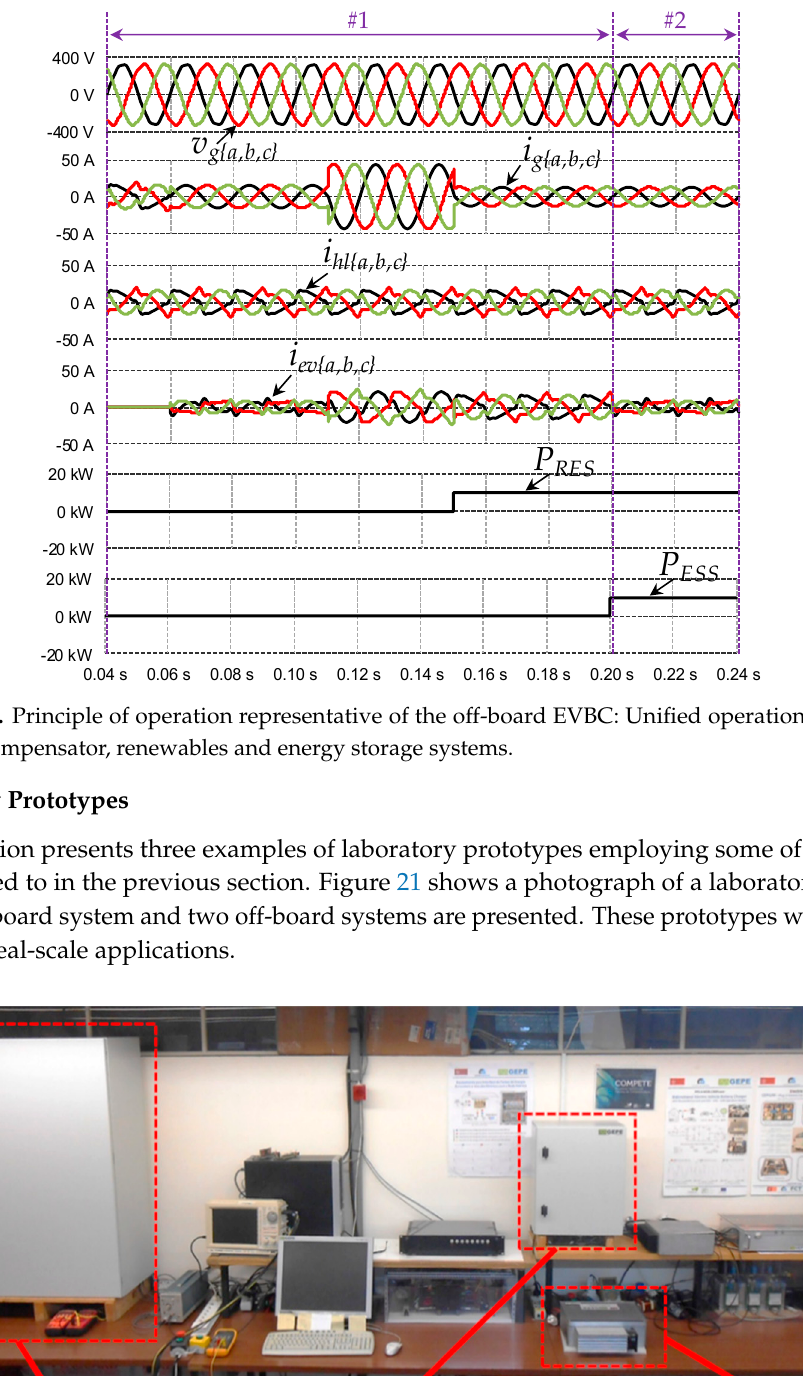
Figure 19. Off-board EVBC: Unified operation of power quality compensator, renewables and energy storage systems.